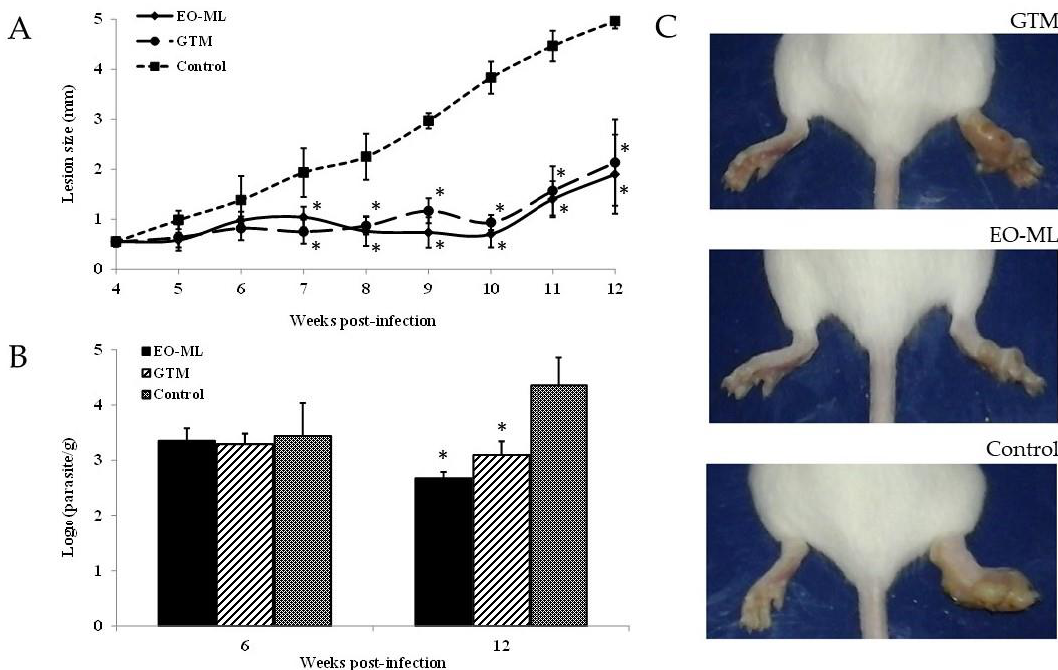
Figure 3. Antileishmanial effect of the essential oil from Melaleuca leucadendra collected in National Botanic Garden, Havana, Cuba, on BALB/c mice infected with 5 × 10 6 promastigotes of L. amazonensis / animal. Treatment started four weeks post-infection with essential oil from Melaleuca leucadendra or Glucantime ® with five doses by the intralesional route at 30 mg/kg every four days. ( A ): Lesion size; ( B ): Parasite burden; ( C ): Pictures at 12 weeks post-infection of infected animals in the footpad with L. amazonensis and treated. EO-ML: essential oil from M. leucadendra ; GTM: Glucantime ® used as reference drug; Control: Untreated animals. *: Displays statistical differences ( p < 0.05) compared to control untreated animals.